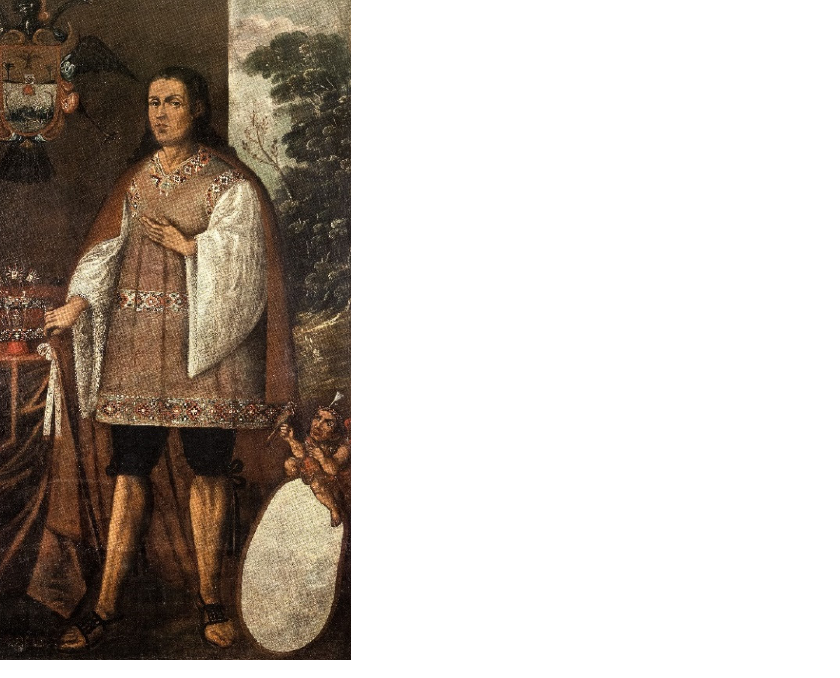
Figure 15. Unidentified artist, Portrait of a cacique , 1700–1730, oil on canvas. Museo Inka, Cuzco. Credit line: Daniel Giannoni from E. Phipps, J. Hecht, C. Esteras Martin, The Colonial Andes: Tapestries and Silverwork, 1530–1830 .